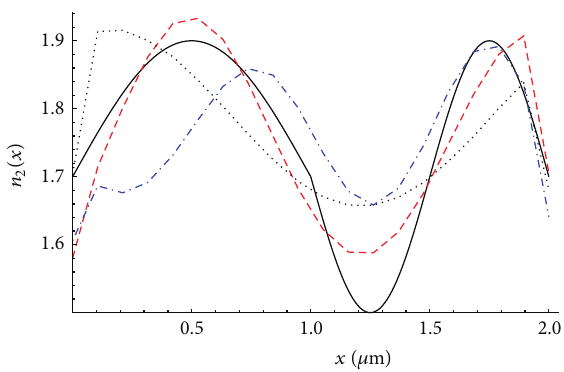
Figure 6: Reconstructed profiles. The solid curve corresponds to the initial profile 𝑛 2 . The red dashed line corresponds to the reconstructed profile at frequencies 65–67 THz, the dotted line cor- responds to 36–38 THz, and the blue dash-dotted line corresponds to 89–91 THz.